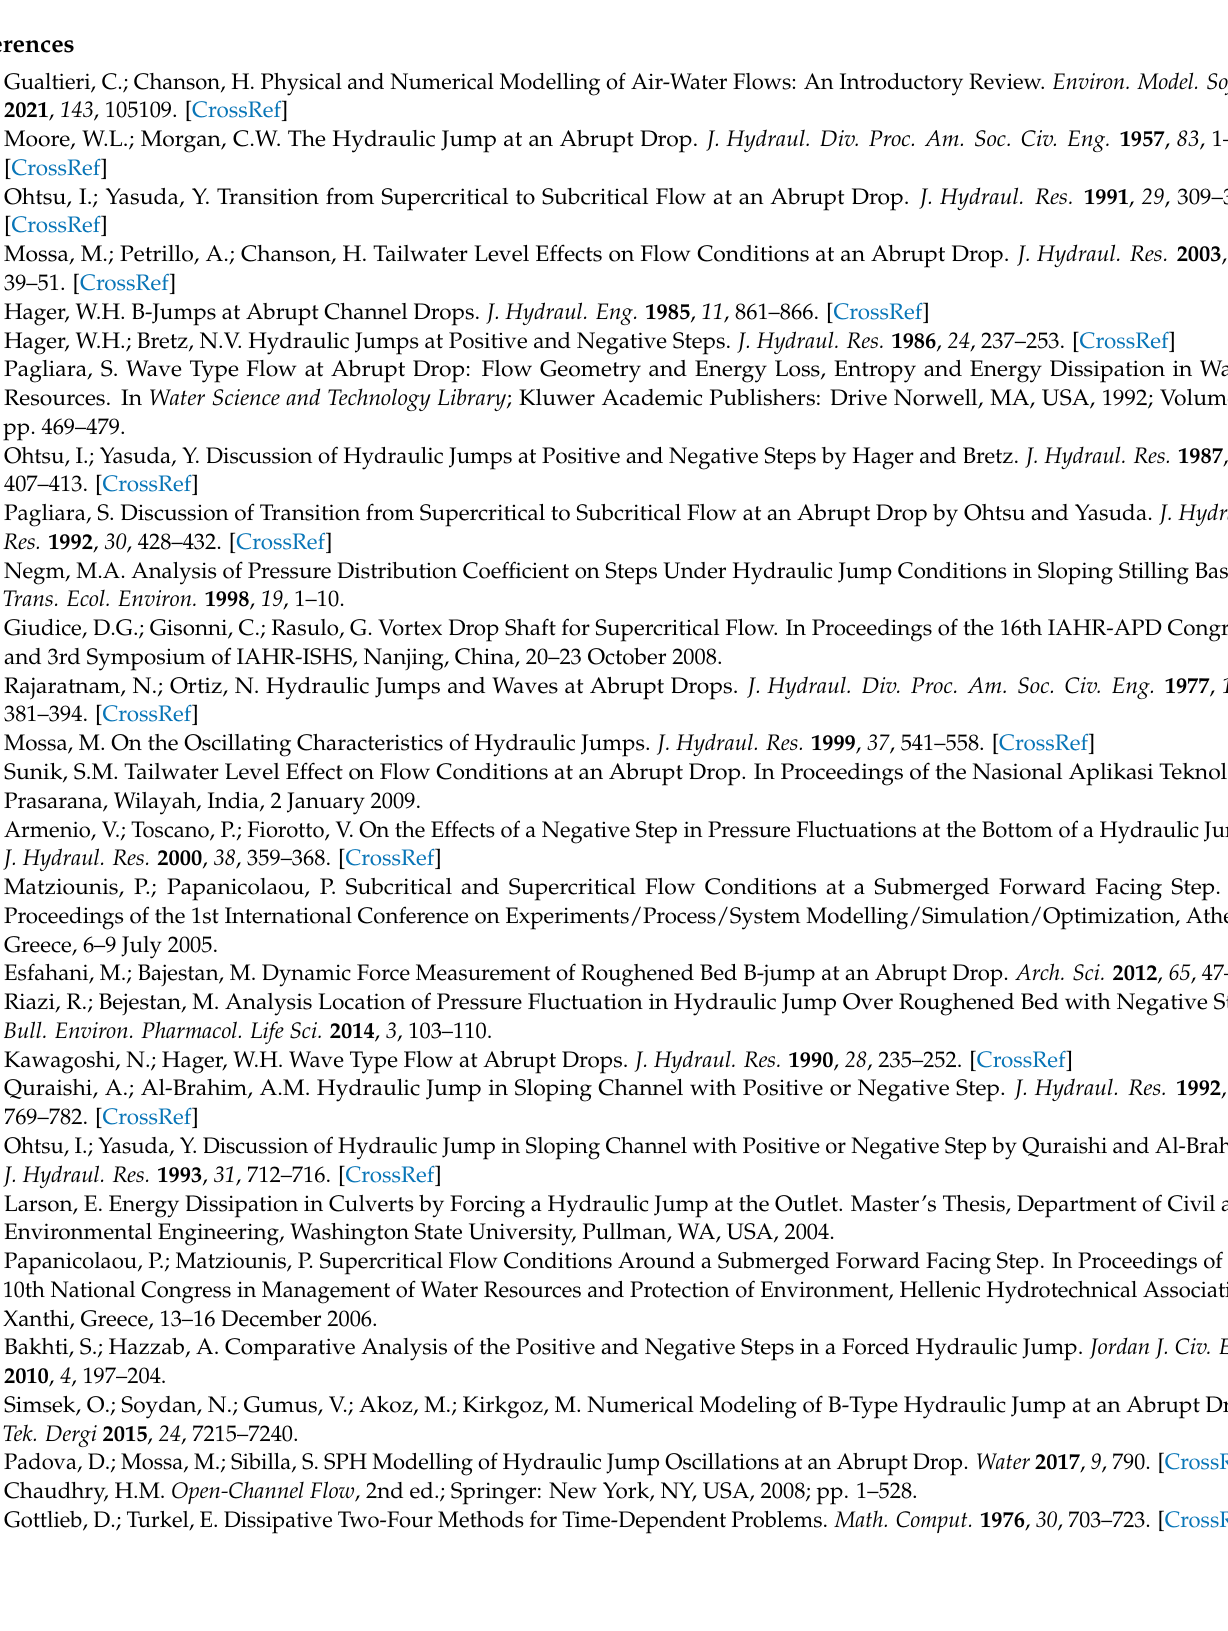
Repeat steps 2–5, with the computed depth and velocity of the present iteration to be the starting values for the next iteration. The algorithm iterates until the change of the depth between two successive iterations in all computational spatial nodes is less than a fixed convergence value. Then the minimum B-jump or the A-jump form as part of the steady state